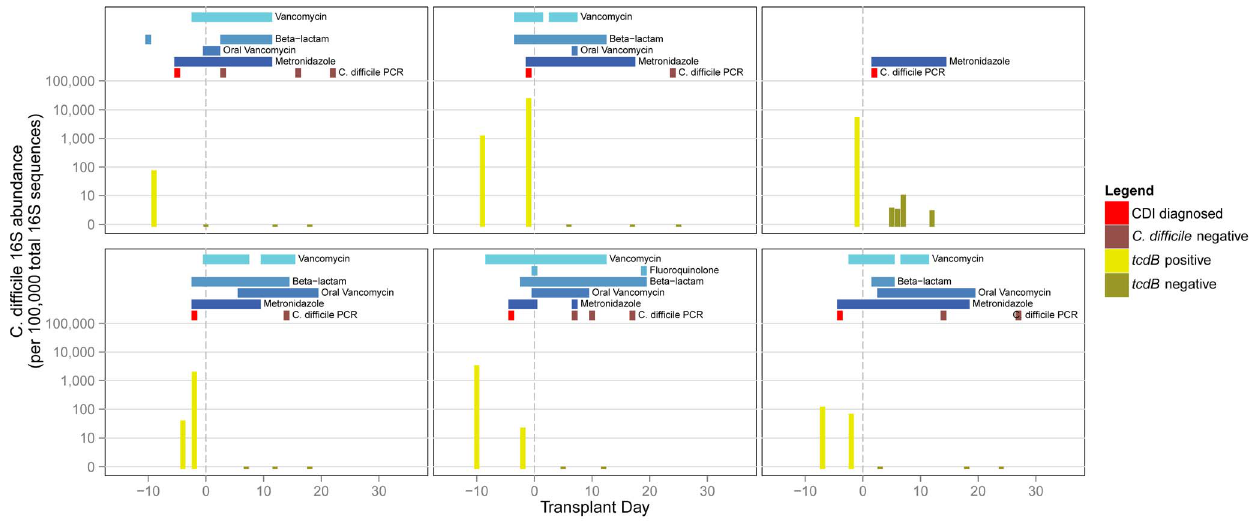
Figure 3. Intestinal composition of C.difficile in six selected cases of CDI. Observed abundance of C. difficile 16S is shown for each fecal specimen in the bargraph over the course of transplantation. The corresponding timing of CDI and antibiotic administration is shown at the top of each plot. Plots of all 94 patients in the biospecimen group can be found in Figure S1.